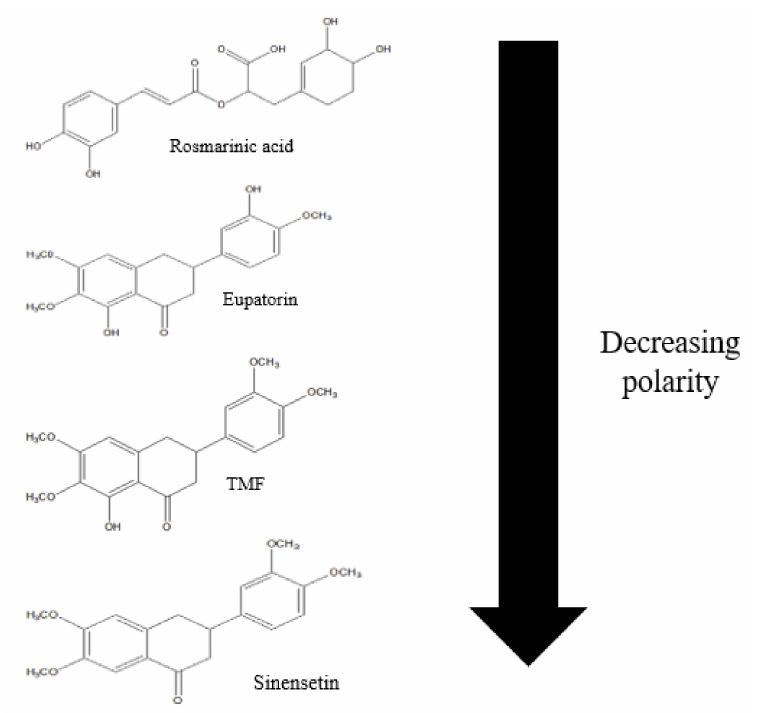
Figure 6. Polarity of the markers of OS. TMF, 3 (cid:48) -hydroxy-5,6,7,4 (cid:48) -tetramethoxyflavone. Rosmarinic acid, which is the most polar compound, was eluted in the first three fractions, Fraction 1 (F1), Fraction 2 (F2), and Fraction 3 (F3). C18 is known as a reversed-phase column